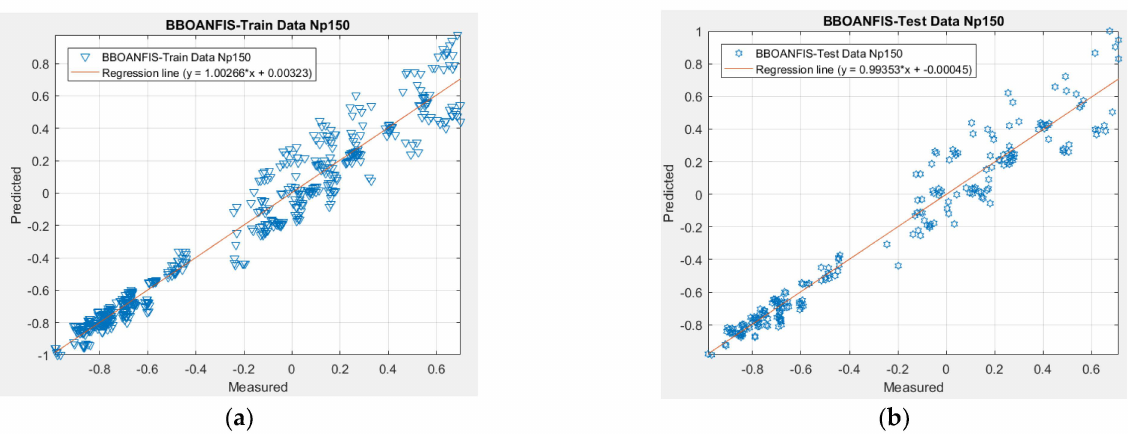
Figure 5. The accuracy of training and testing dataset performance of BBO − ANFIS in the best-fit optimization structure: ( a ) BBO − ANFIS train Np = 150; ( b ) BBO − ANFIS test Np = 150.